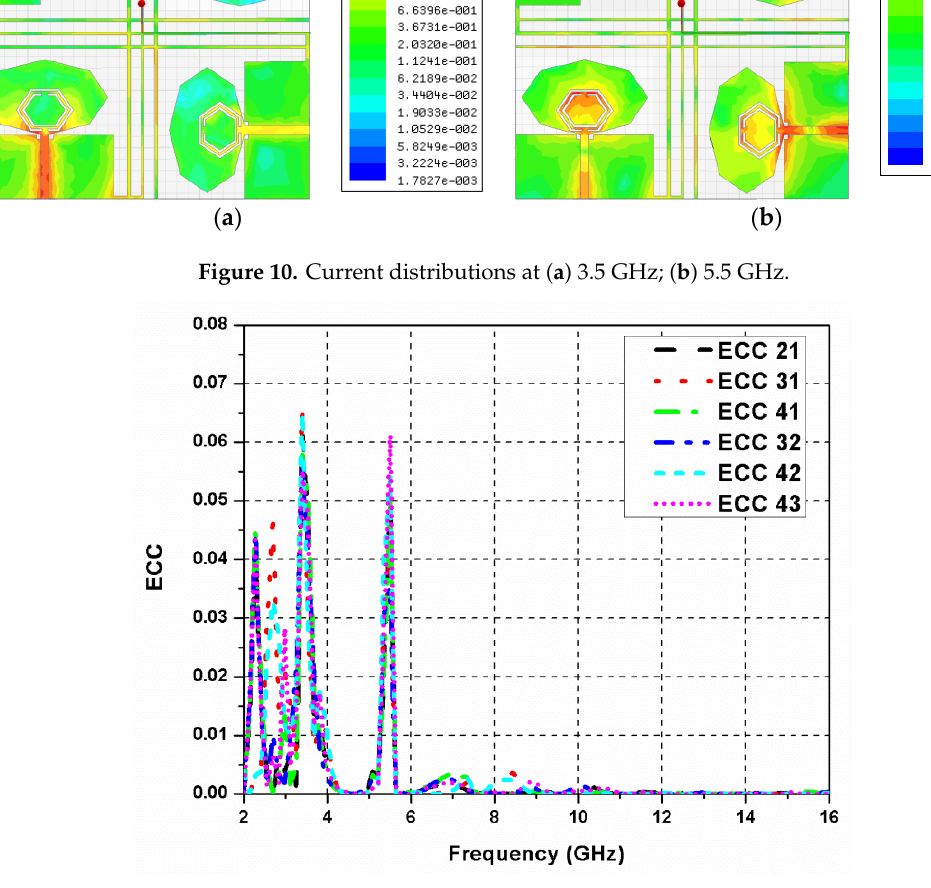
Figure 11. Envelope correlation coefficient (ECC) of the proposed four-port ultra-wideband (UWB) MIMO antenna.